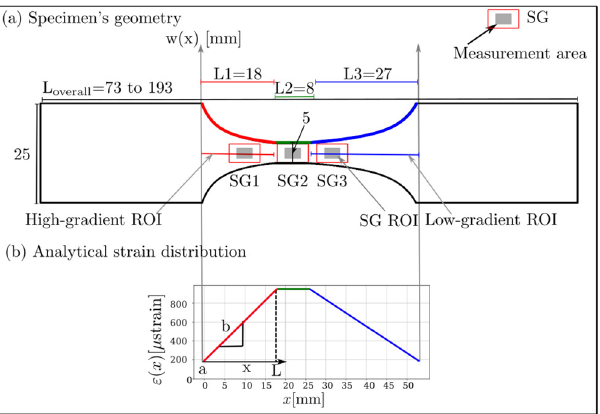
Figure 1. ( a ) Specimen’s geometry derived from Eq. (12), w ( x ) shows how the curvature of the specimen changes; in red and blue the high- and low-gradient ROIs are shown, respectively. L1 is the high-gradient ROI and where SG1 is placed. L2 is a neutral ROI connecting the high-gradient ROI with the low-gradient ROI, L2 shows constant strain and where SG2 is placed. L3 is the low-gradient ROI and where SG3 is placed. ( b ) The theoretical strain distribution along the specimen’s length. The high- and low-strain gradients are shown in red (steeper curve) and blue, respectively. Constant strain (in green) connects both gradient